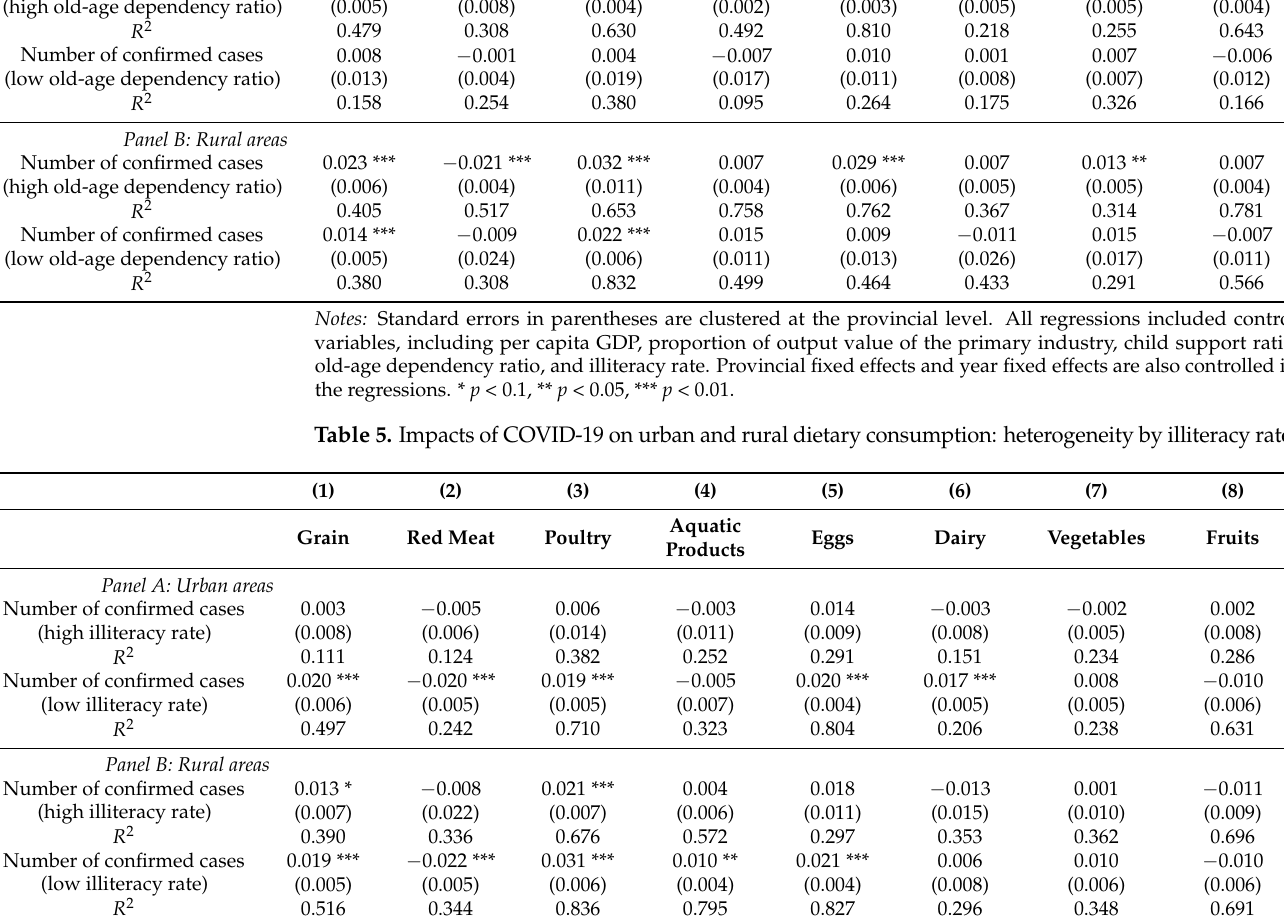
Aquatic Eggs Dairy Vegetables Fruits Products